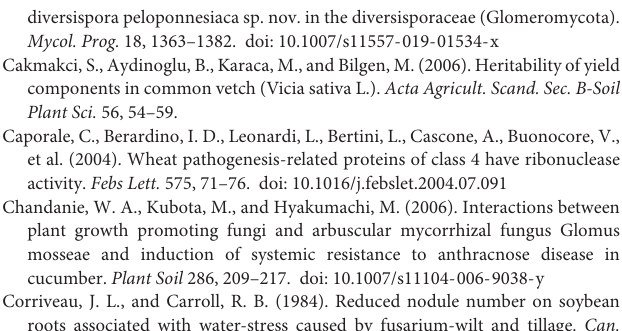
Supplementary Figure 1 | Unigene length distribution. Supplementary Figure 2 | qRT-PCR verification results of differential gene expression. NM = uninoculated with S. tortuosa , AM = inoculated with S. tortuosa , NMP = NM inoculated with C. lentis , and AMP = AM inoculated with C. lentis . Supplementary Table 1 | Summary statistics for sequencing for four libraries from NM, AM, NMP, and AMP samples. Supplementary Table 2 | qRT-PCR verification of gene primer information